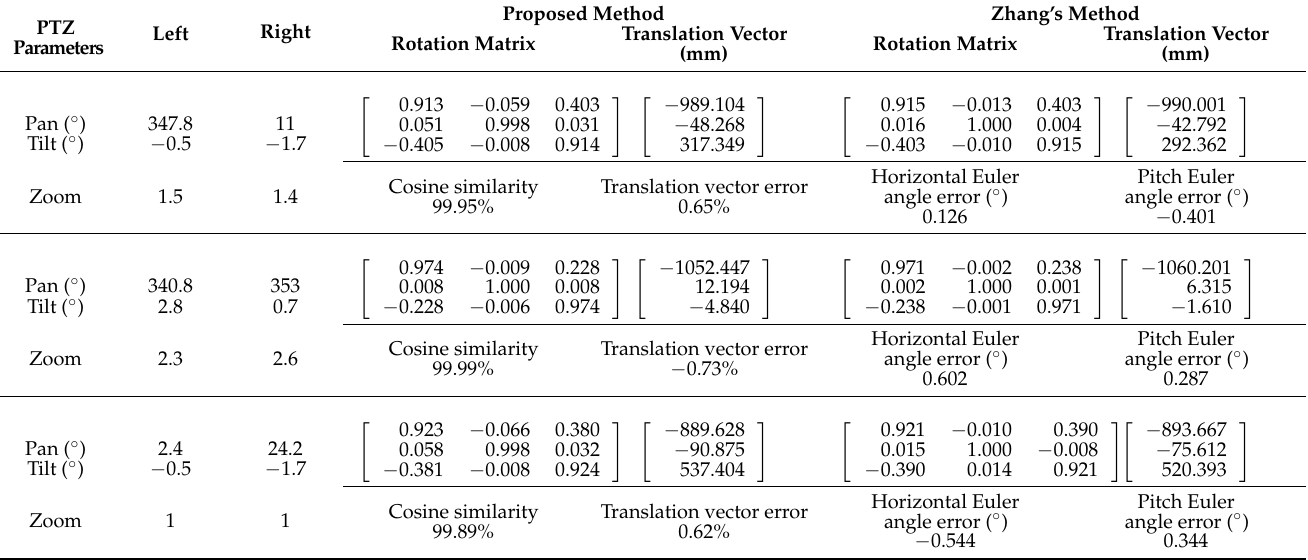
Table 5. Comparison between extrinsic parameters of our data and the ground